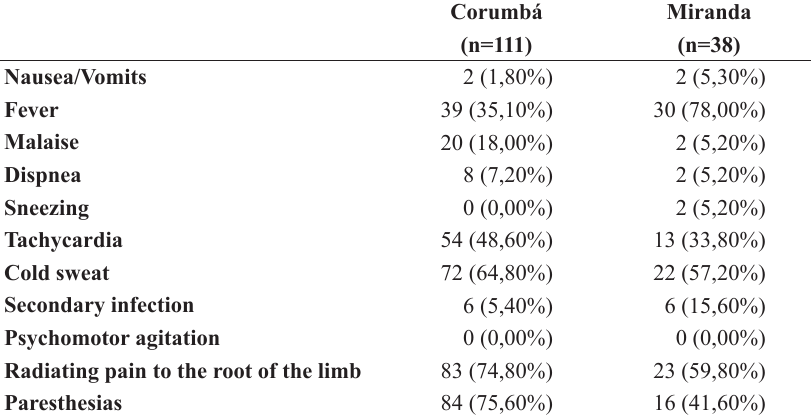
Systemic manifestations caused by Pseudoplatystoma stings in professional fishermen of Corumbá and Miranda towns